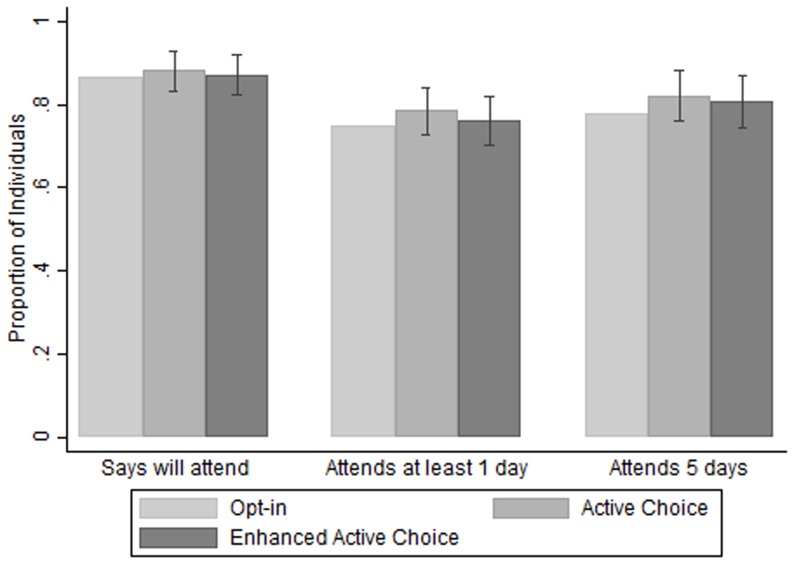
Impact of Invitation Type on Potential and Actual Business Training Attendance.Opt-in bars represent attendance rates for the opt-in invitation group. Bars for the active choice and enhanced active choice groups are the sum of the opt-in rate and the treatment coefficient estimated by OLS regression. OLS regression includes controls for marketplace. Lines on the active choice and enhanced active choice treatment bars represent plus or minus 1.96 times the standard error of the treatment coefficient. Attended all 5 days is conditional on attending at least one day.